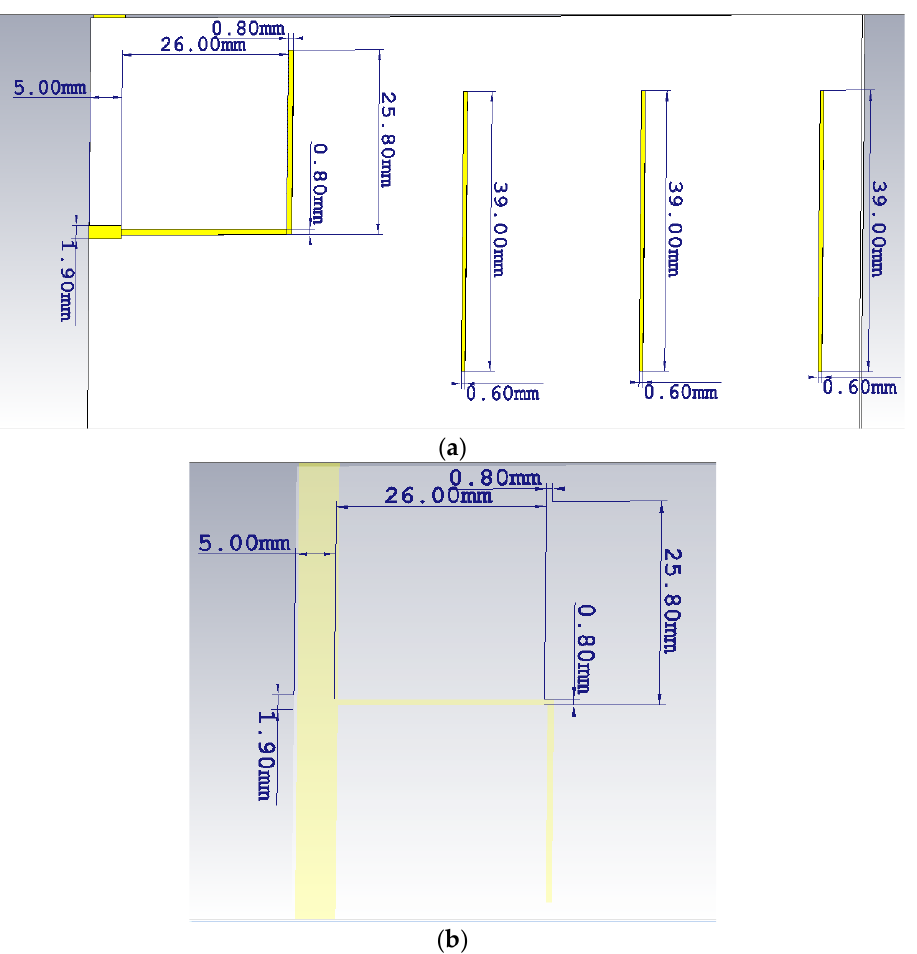
Figure 5. ( a ) Yagi–Uda element—Top view.; ( b ) Yagi–Uda element—Bottom view. Simulating with high dense meshing on the conductors, we obtained the results in Figure 6: From the cartesian plots, we see that the peak-to-sidelobe (PSL) ratio in the azimuth axis was ~25 dB, which was much higher than the elevation’s PSL of ~10 dB. Consequently, further GL suppression by the element is possible in the azimuth axis, and thus, higher distancing between elements in this direction is also